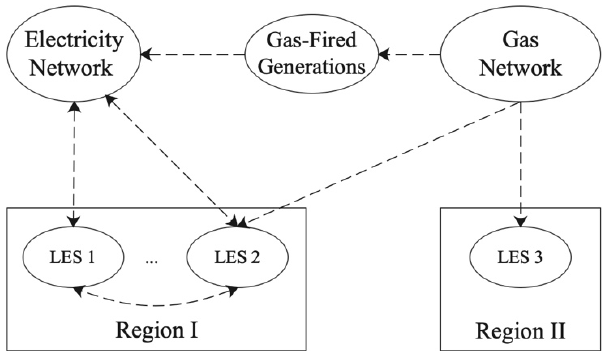
Figure 1. Framework of the interconnected LESs.